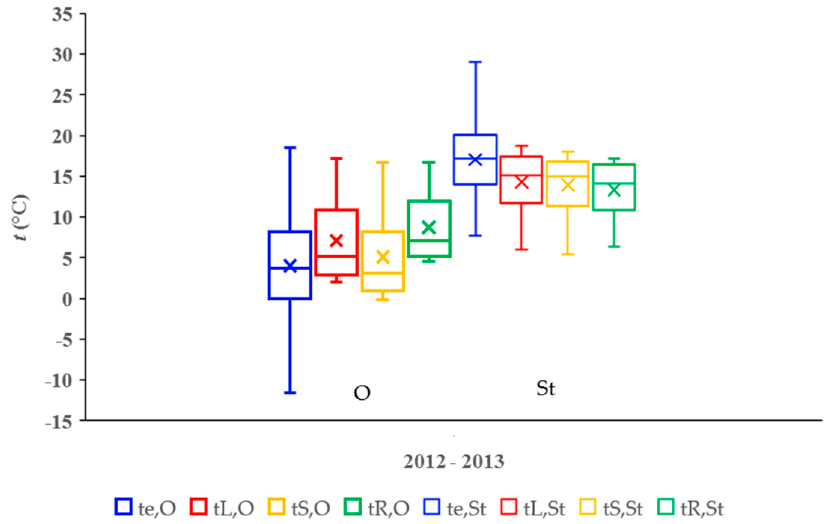
Figure 3. Box plot of temperatures of ground mass with linear HGHE ( t L , O , t L , St ), slinky HGHE ( t S , O , t S , St ), reference ground mass ( t R , O , t R , St ), and ambient temperatures ( t e , O , t e , St ) during the heating season 2012/2013 (O) and the period of stagnation of the HGHEs in 2013 (St). The modes of the observed average daily temperatures in the heating period, except for the temperatures of the reference ground mass t R , O , were within the interval [4.10, 6.00] ◦ C. However, the frequency of temperatures varied. The relative frequency reached the highest value w i =